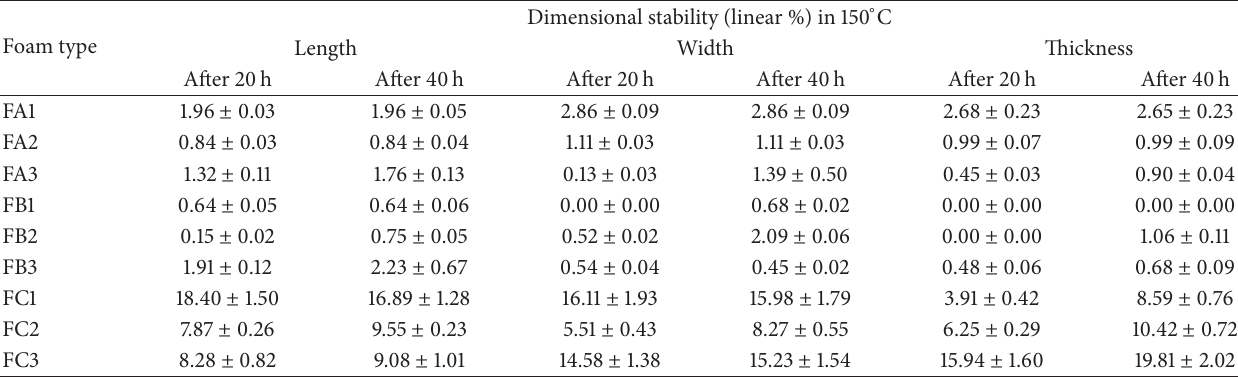
Table 5: Dimensional stability of polyurethane foams.